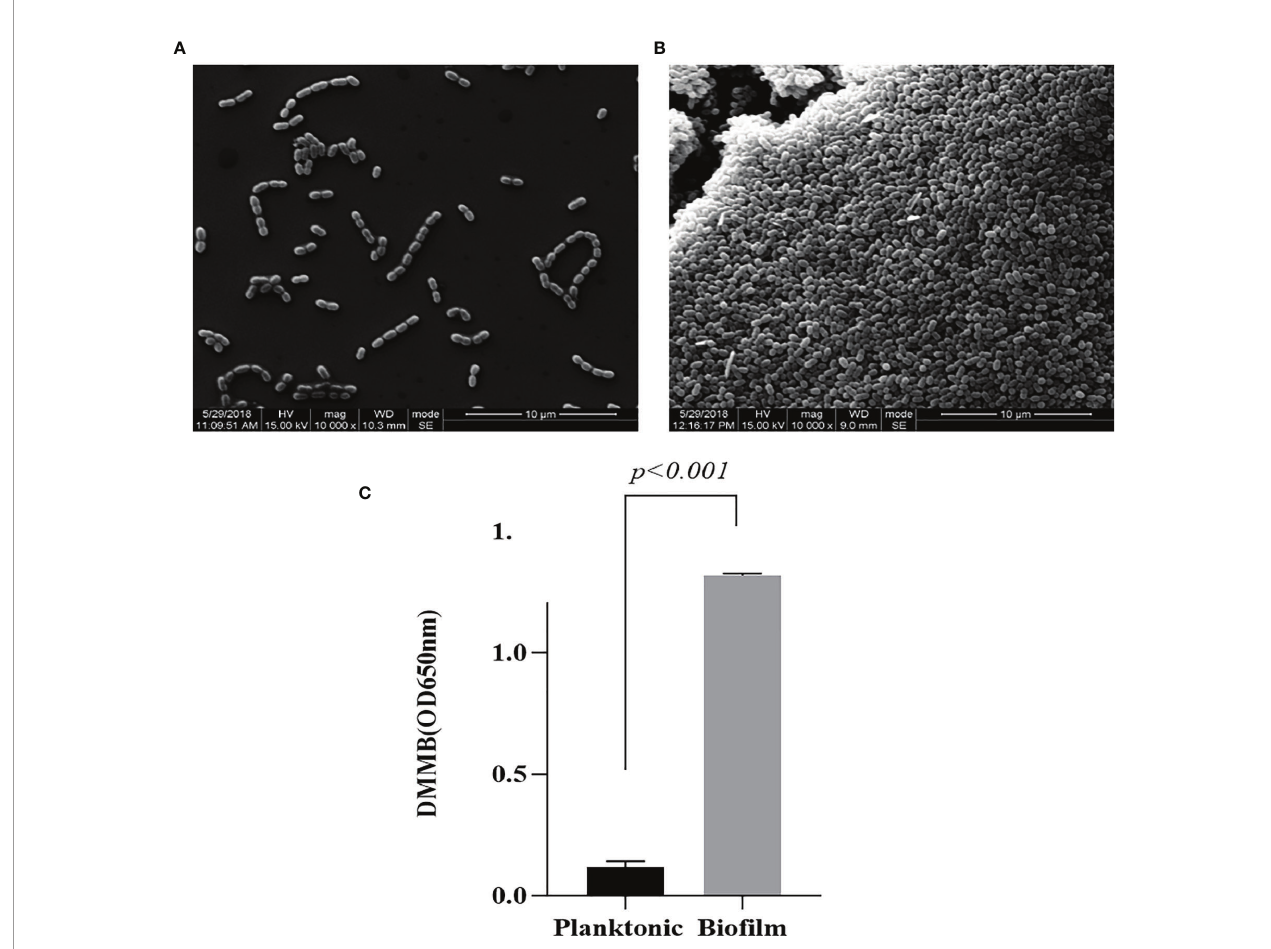
FIGURE 1 | Difference between Lactococcus garvieae planktonic type and bio fi lm type. (A) L. garvieae planktonic type. (B) L. garvieae bio fi lm type. (C) The mean values of L. garvieae planktonic type and bio fi lm type DMMB under the same 10 7 CFU/ml. Mean p -values were calculated by one-way ANOVA ( p <